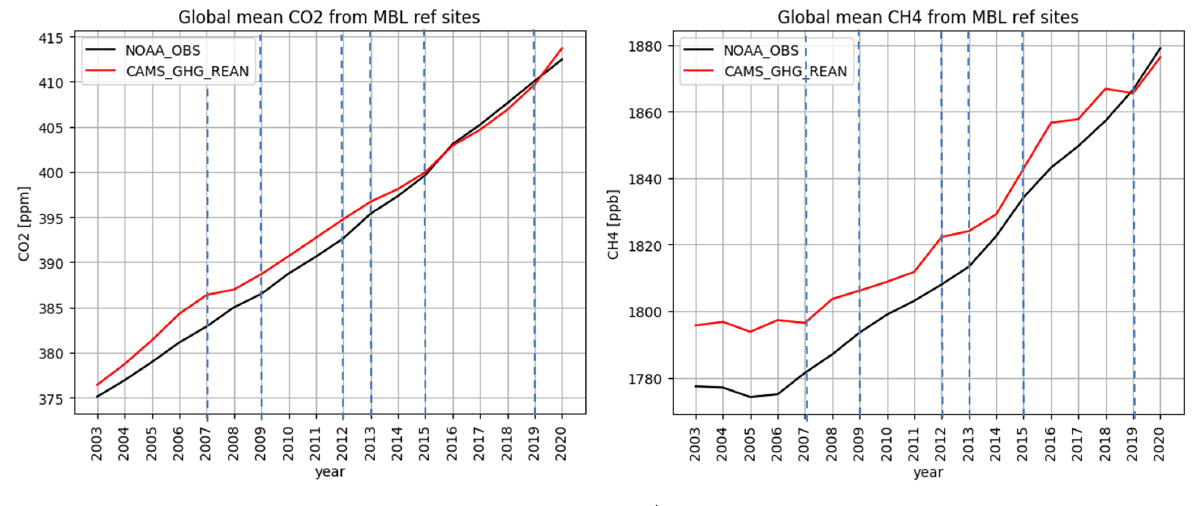
Figure 15. Global mean CO 2 (ppm) and CH 4 (ppb) from the CAMS GHG reanalysis (in red) and the NOAA global mean CO 2 and CH 4 (in black, https://gml.noaa.gov/ccgg/trends/global.html, last access: 18 March 2023) based on the Greenhouse Gas Marine Boundary Layer Reference (Conway et al., 1994; Dlugokencky et al., 1994, 2021; Masarie and Tans, 1995). The global mean of the CAMS GHG reanalysis has been computed based on the same NOAA marine boundary layer (MBL) reference sites shown in Fig. 7 (see https://gml.noaa.gov/ccgg/ mbl/mbl.html for further details). The dashed blue lines mark the years when there was a change in the observing system. The uncertainty associated with the computation of global mean using the MBL sites is estimated to be 0.1ppm for CO 2 (Ed Dlugokencky and Pieter Tans, NOAA/GML, https://gml.noaa.gov/ccgg/trends) and below 2ppb for CH 4 (Ed Dlugokencky, NOAA/GML; https://gml.noaa.gov/ccgg/